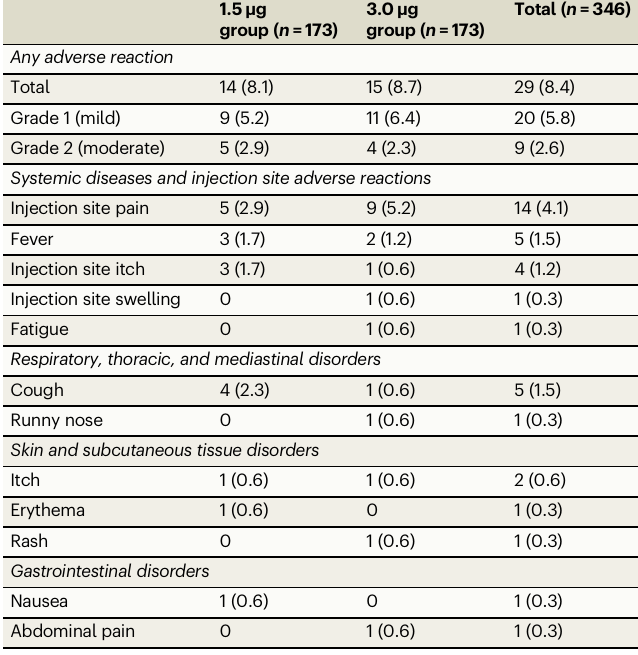
Data are n (%), representing thetotal number of participants whohad adverse reactions (i.e., adverseevents related to